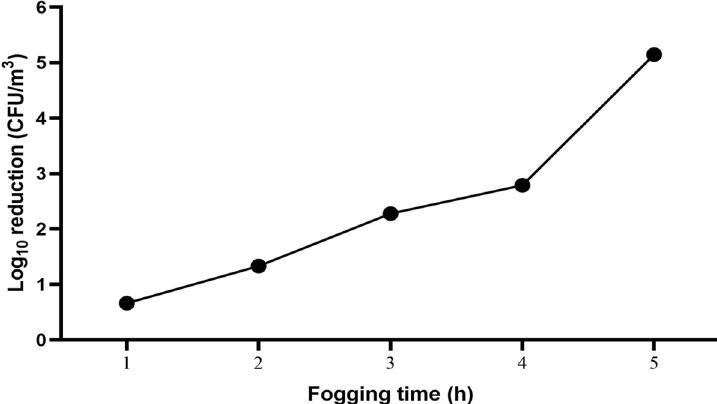
Fig 7. Reduction of bacterial load (Log 10 CFU/m 3 ) over time enumerated using plate count technique.